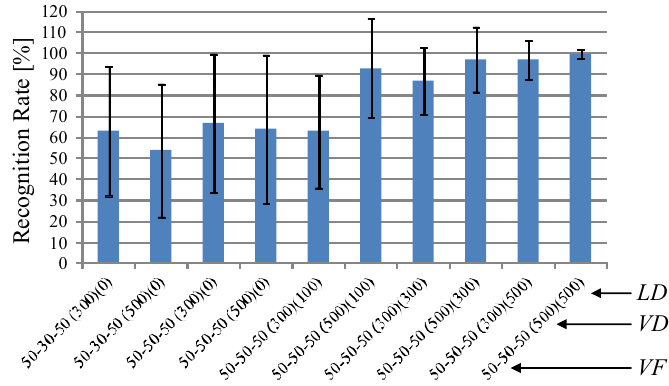
Fig. 16 Average Recognition Rate of five Subjects